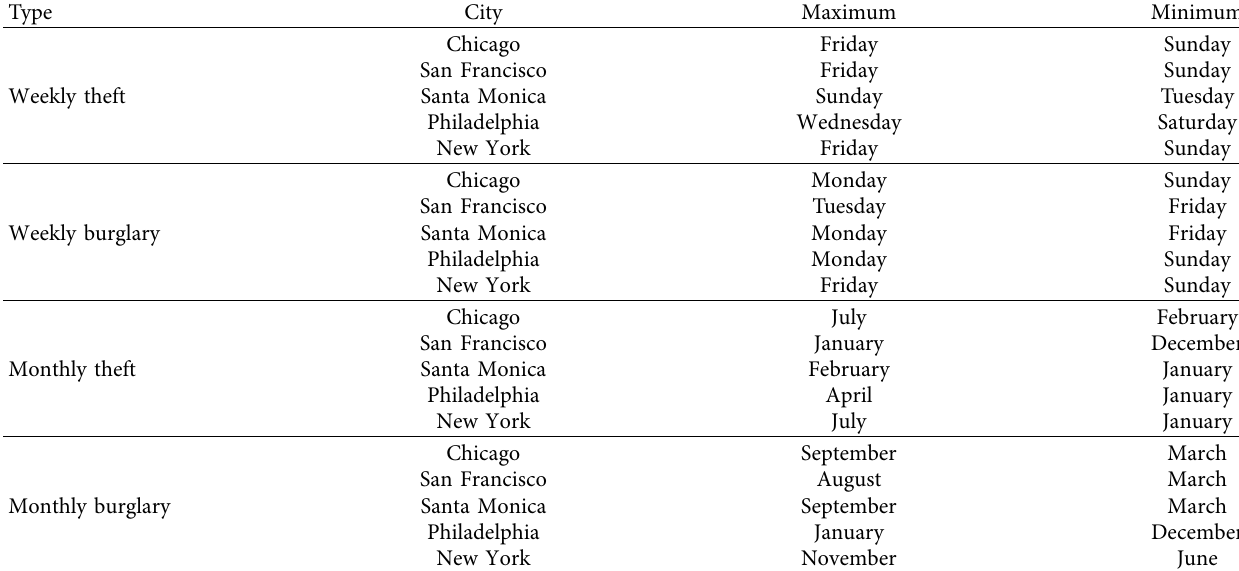
Figure 6: Burglary and theft weekly and monthly trends across cities. The line charts are the monthly trends of theft in Chicago in 2018. The bar chart is the distribution of the clusters. Table 2: Temporal patterns in five cities in